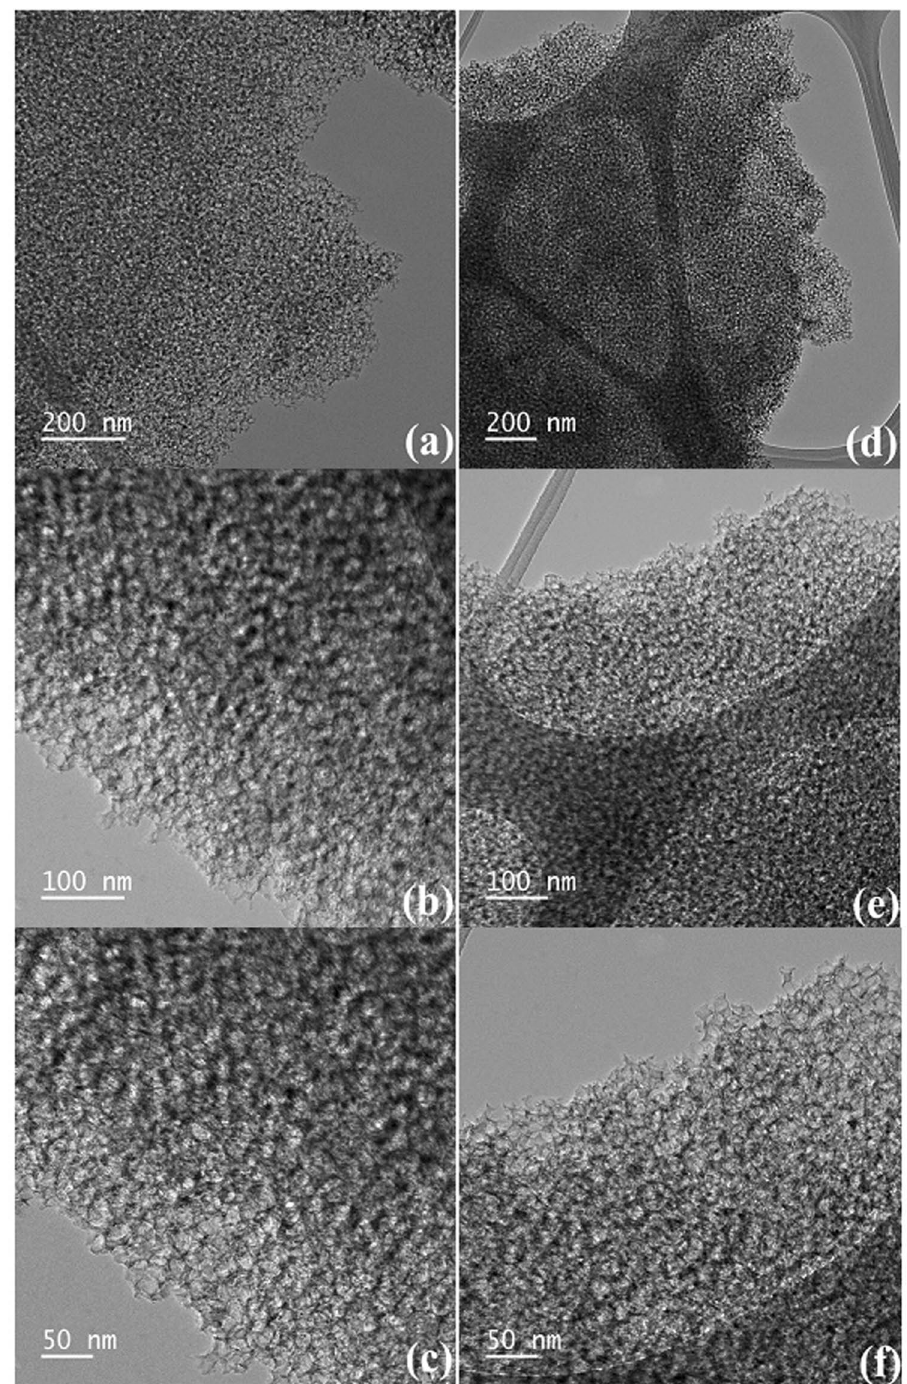
Figure 3. TEM images of CCO ( a–c ) and Au(Salen)@CC ( d–f